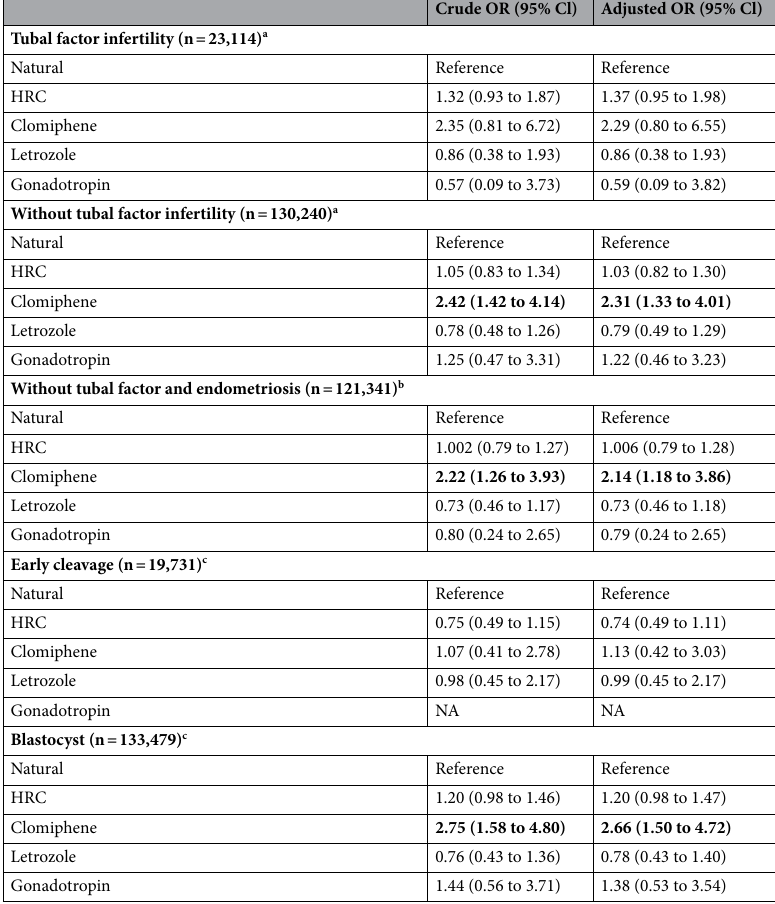
Table 3. Subgroup analysis of crude and adjusted ORs for ectopic pregnancy with endometrial preparation protocols. Significantly increased or reduced odds are indicated by boldface. CI confidence interval, HRC hormone replacement cycle, NA not available, OR odds ratio. a Adjusted for maternal age, infertility diagnosis of endometriosis, male factor, other or unexplained and year. b Adjusted for maternal age, infertility diagnosis of male factor, other or unexplained and year. c Adjusted for maternal age, infertility diagnosis of tubal factor, endometriosis, male factor, other or unexplained and